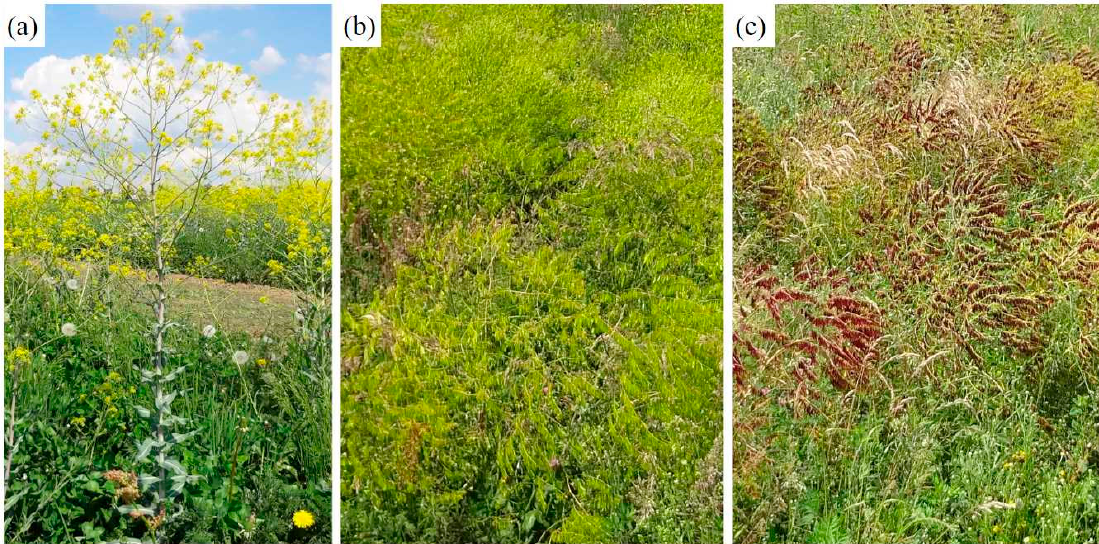
Figure 2. Woad plant morphology in the second year of cultivation ( a ); changing color of ripening siliques from light green ( b ) to dark brown ( c ) (Source: this study).